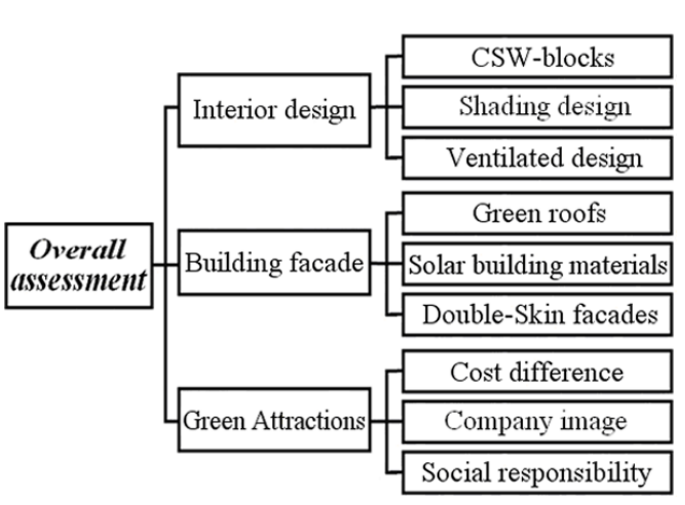
Figure 2. AHP hierarchical framework for each